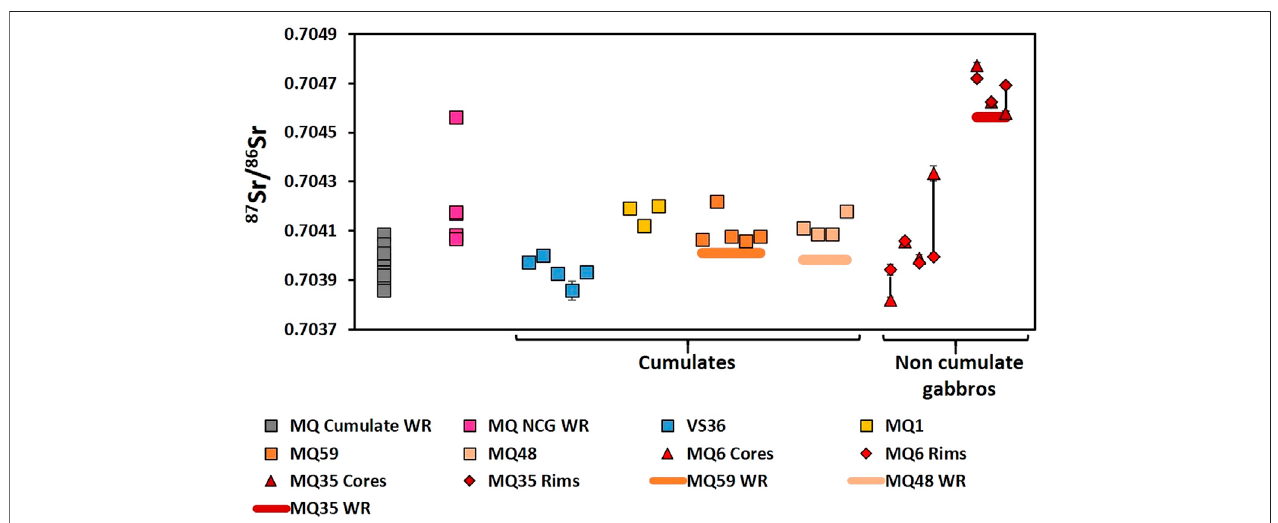
FIGURE 6 | Details of 87 Sr/ 86 Sr variation in cumulate and NCG plagioclase. The whole rock 87 Sr/ 86 Sr range for Martinique cumulates and NCG ’ s is plotted for comparison. Whole rock data for individual samples shown as colored bars (bar width covers uncertainty). Where visible, black bars show uncertainty (2 SE), otherwise uncertainty is smaller than symbol size. Core-rim pairs are joined by tie lines.